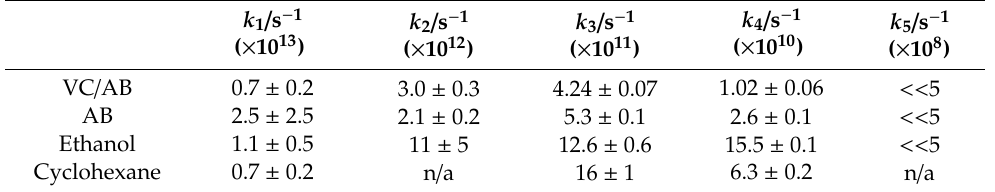
Table 3. Summary of the rate constants ( k n ) resulting from sequential global fit of the TAS of DES in VC / AB, AB, ethanol and cyclohexene. Reproduced and adapted with permission from [115], licensed under CC BY 4.0. Published by Springer